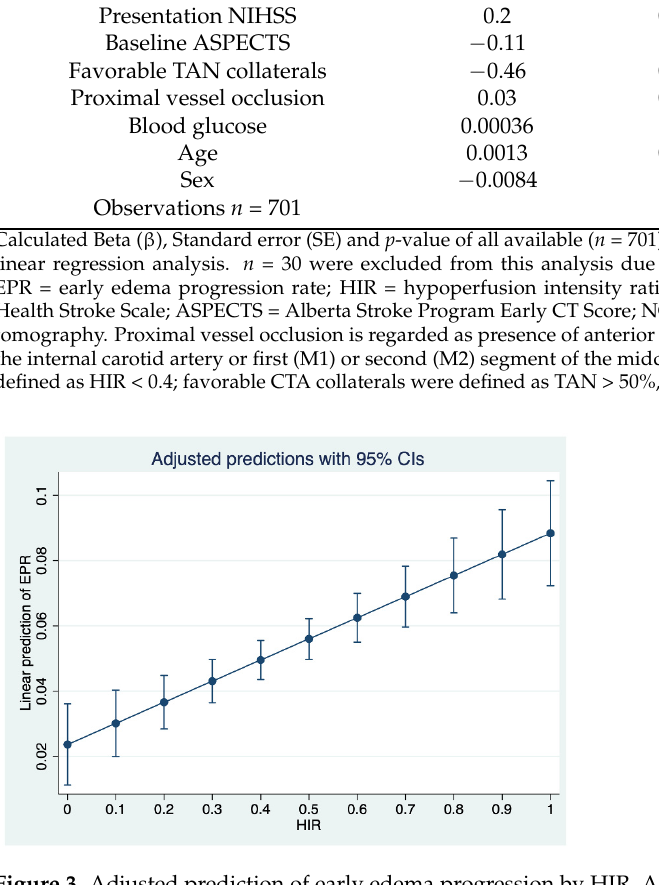
Table 3. Linear multivariable regression analysis for primary outcome (EPR).